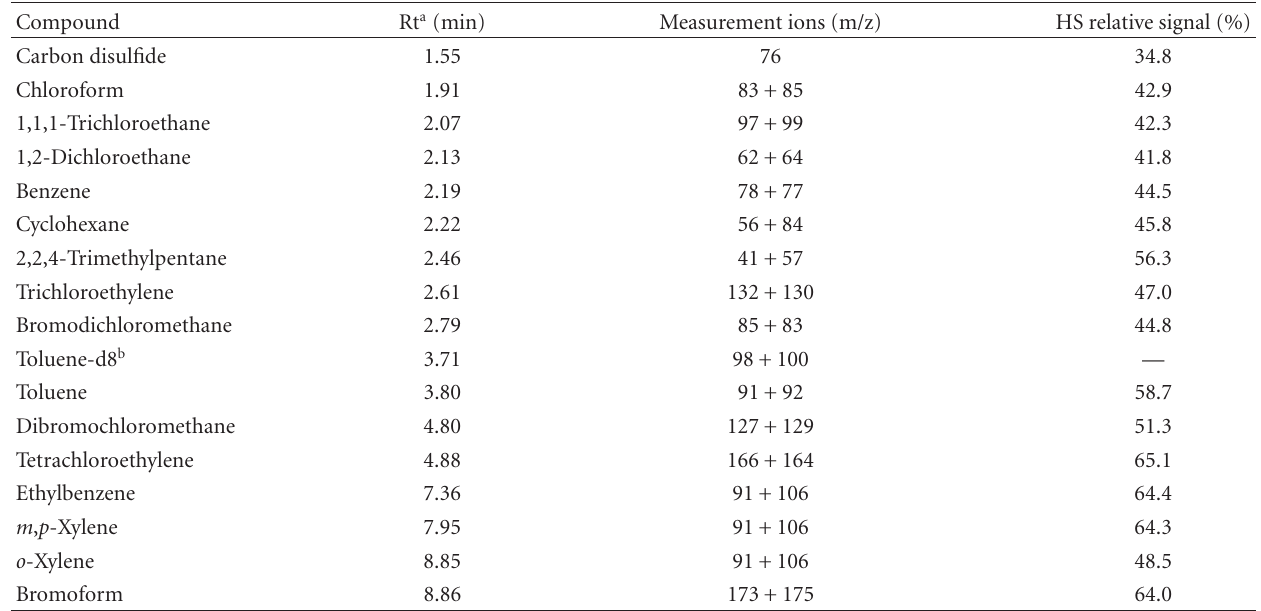
Table 1: GC-MS measurement parameters of VOCs under